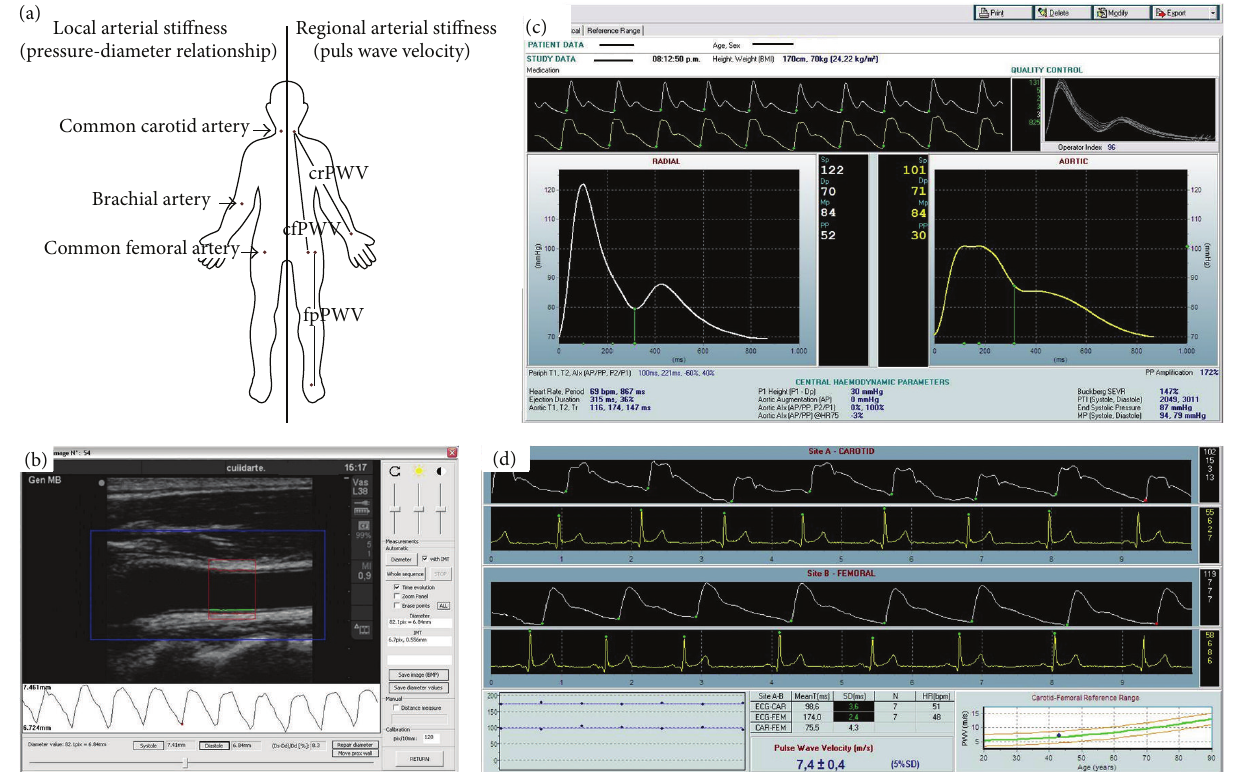
Figure 1: (a): Local (left) and regional (right) sites of arterial stiffness noninvasive evaluation. (b) Diameters border detection applied recreating common carotid artery diameter waveforms. (c) SphygmoCor Software, to determine central aortic blood pressure (levels and waveform) from radial pulse waveforms recordings. (d) SphygmoCor Software to determine arterial pulse wave velocity, from the